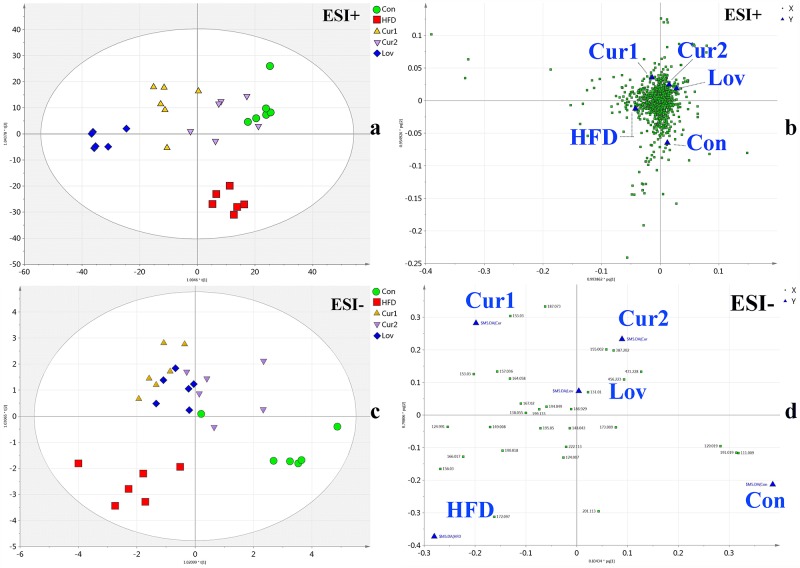
OPLS-DA analysis of UPLC-Q-TOF/MS data of five groups.Score plots in positive and negative modes were labeled as a and c, corresponding loading plots were assigned as b and d.